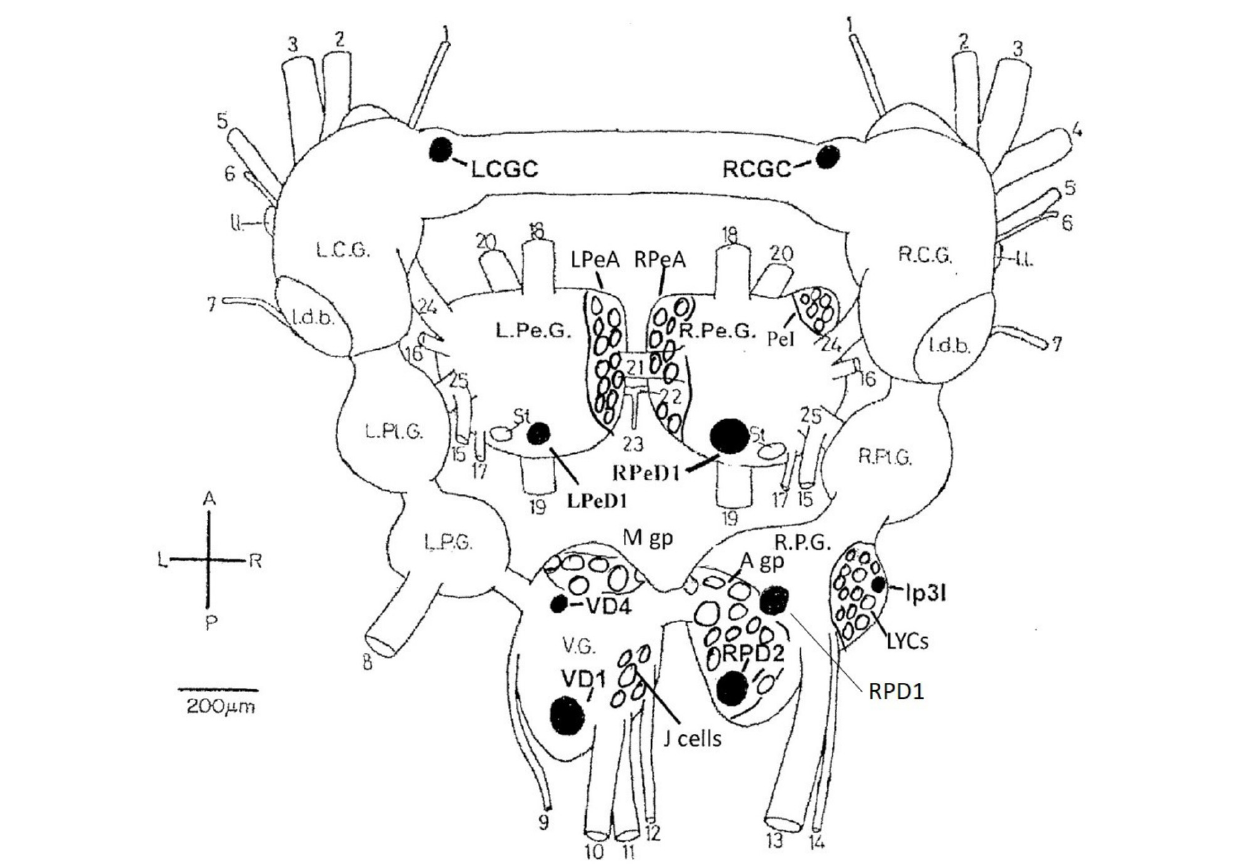
FIGURE 1 | Dorsal view of the central nervous system of Lymnaea stagnalis (L.) with the exception of the paired buccal ganglia. The diagram shows locations of individual neurons (black), cell groups and clusters (clear) identified in the text. LCGC and RCGC, left and right cerebral giant cells; RPeD1, right pedal dorsal cell 1; LPeD1, left pedal dorsal cell 1 VD1 and VD4, visceral dorsal cells 1 and 4; RPD1 and RPD2, right parietal; dorsal cells 1 and 2; Ip3I, input 3 interneuron; A gp, right parietal A group; M gp, visceral M group; LPeA and RPeA, left and right pedal A group cells; PeI, pedal I group cells. A, anterior; P, posterior; L, left; R. right. L.C.G. and R.C.G, left and right cerebral ganglia; L.Pe.G. and R.Pe.G., left and right pedal ganglia; L.Pl.G. and R.Pl.G., left and right pleural ganglia; L.P.G. and R.P.G., left and right parietal ganglia: V.G., median visceral ganglion; Idb., lateral dorsal body; II., lateral lobe; St, statocyst. (1) cerebro-buccal connective: (2) superior